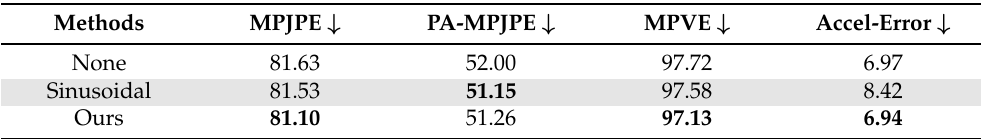
Table 3. Comparison of refinement performance of HPR-Net according to positional encod- ing method. Bold values indicate best results.